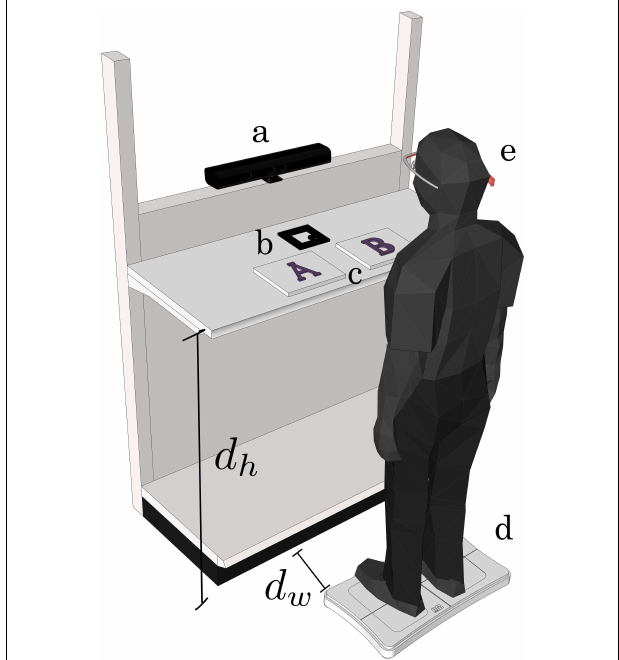
FIGURE 1 | Experimental setup of shelf: a, webcam; b, AR marker for locating of the center of the two alternatives; c, items horizontally aligned; d, Wii Balance Board (WBB); and e, eye tracker (EMR-9). Shelf top height d h = 98 (cm) and distance between WBB and shelf d w = 35 (cm). The subject wearing the eye tracker stands on a WBB after the operator gives a cue. The shelf was a commercial shelf used in real stores.